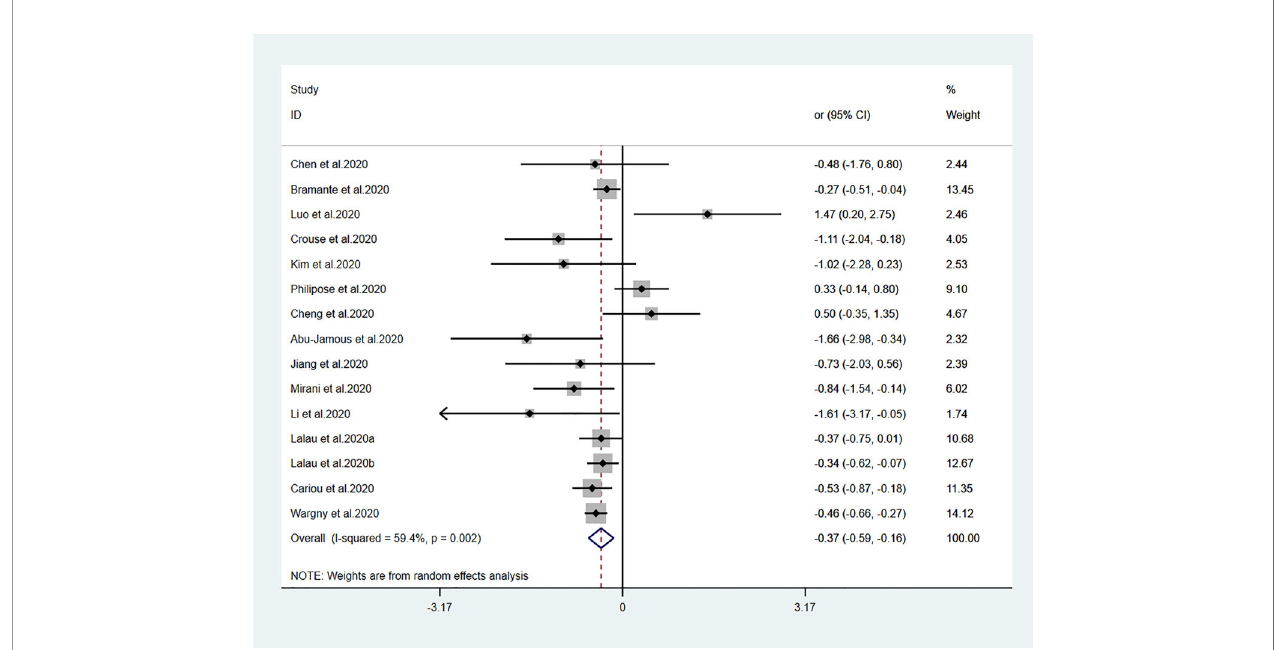
FIGURE 2 | Forest plots of meta-analysis of the relationship between metformin therapy and the risk of mortality in patients with type 2 diabetes who have COVID- 19. The diamonds and horizontal lines indicate the corresponding odds ratio and 95% con fi dence interval. The size of the gray area represents the speci fi c statistical weight of the study. The vertical solid line represents the OR of 1, and the vertical red dotted line shows the combination effect estimation. The suf fi x “ a ” or “ b ” after the studies indicates results of the same study at different